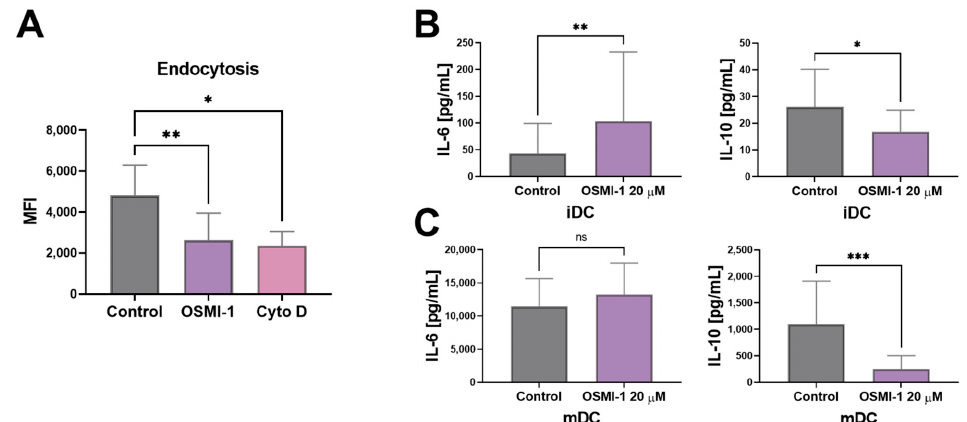
Figure 4. The impact of OSMI-1 on endocytosis and the release of cytokines. ( A ) Control or immature OSMI-1-moDCs were incubated with FITC-labelled dextran particles (molecular weight ≈ 40.000 Da) for 1 h. Cells incubated with cytochalasin D were used for a negative control. Endocytosis of FITC-conjugated dextran particles was determined by flow cytometry and the subtraction of MFIs of FITC positive cells at 37 °C with the MFI values obtained at 4 °C. Bars present the mean MFI values ± SD of six independent experiments. Cytokines concentration measured by CBA method in supernatants of untreated or OSMI-1 treated immature ( B ) and mature ( C ) moDCs, on day 6 or 8, respectively. Shown are mean concentrations ± SD of four to seven independent experiments. Statistical significance between individual pairs was calculated using Student’s t -test; p -value < 0.05 was considered statistically significant (* p < 0.05; ** p < 0.01; *** p < 0.001; ns, nonsignificant). iDCs, immature moDCs; mDCs, mature moDCs; Cyto D, cytochalasin D.